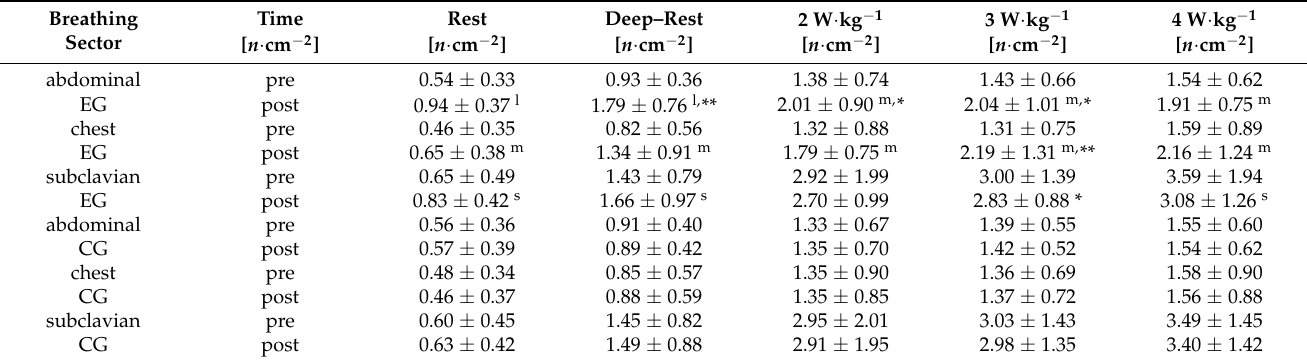
Table 1. Average values measured by probes and standard deviations of pressure on individual breathing sectors at rest and at different load intensities in the experimental group (EG) and control group (CG).